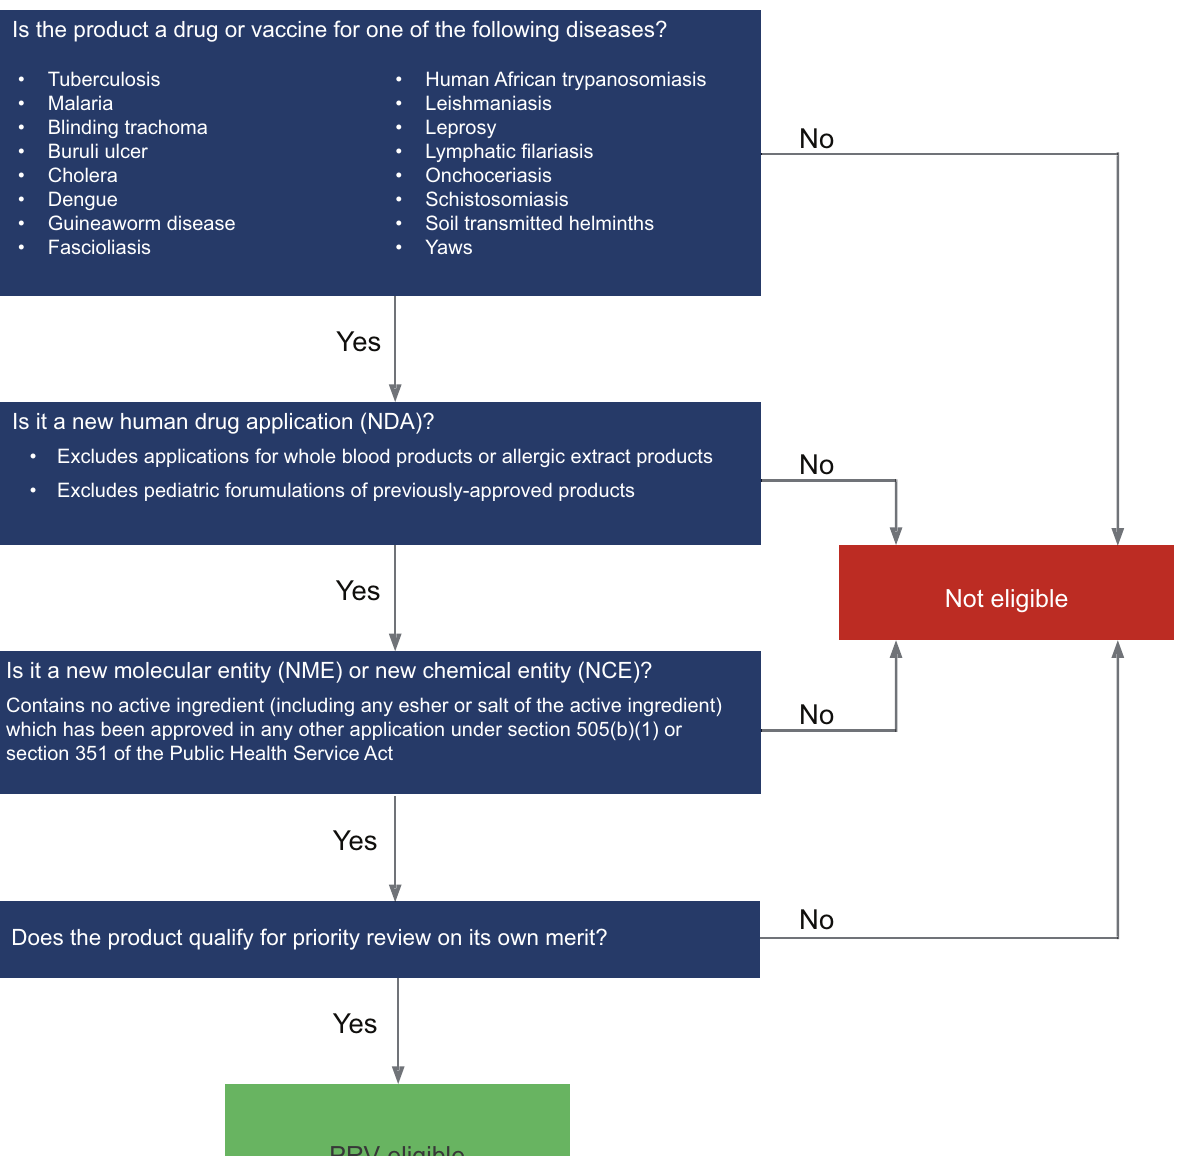
PLOS Neglected Tropical Diseases |